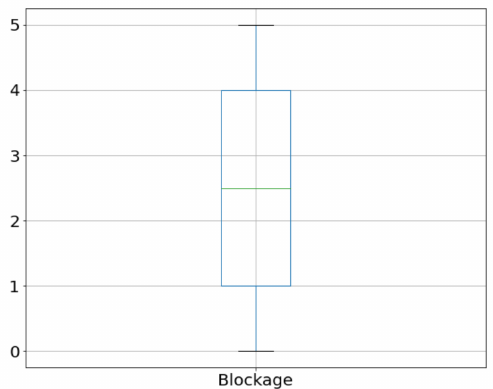
Figure 7. Blockage distribution after data preprocessing using the SMOTE